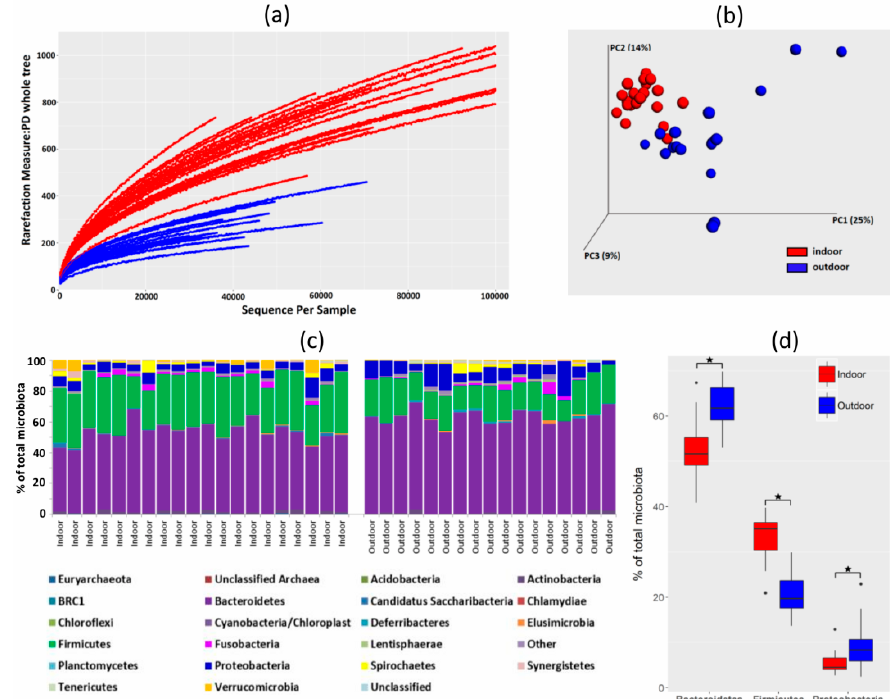
Figure 2. Microbiota of indoor and outdoor hens. ( a ) Rarefaction curves of individual hens from indoor, commercial flocks (red color) and outdoor, backyard flocks (blue color). ( b ) Weighted principal coordinate analysis (PCoA) analysis of caecal microbiota of individual hens from commercial flocks (red color) and backyard flocks (blue color). ( c ) Composition of caecal microbiota of individual hens from indoor and outdoor flocks at the phylum level. Of the majority phyla, microbiota of chickens from indoor commercial flocks was enriched for Gram-positive Firmicutes while microbiota of outdoor, backyard, chickens was enriched for Gram-negative Bacteroidetes and Proteobacteria (Panel ( d )). * significantly di ff erent abundance in indoor and outdoor chickens by Mann–Whitney test, p <